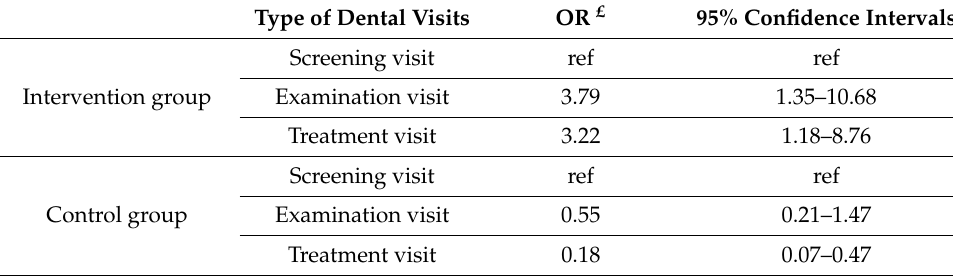
Table 9. The effects of different visits on the Frankl scores of each group.